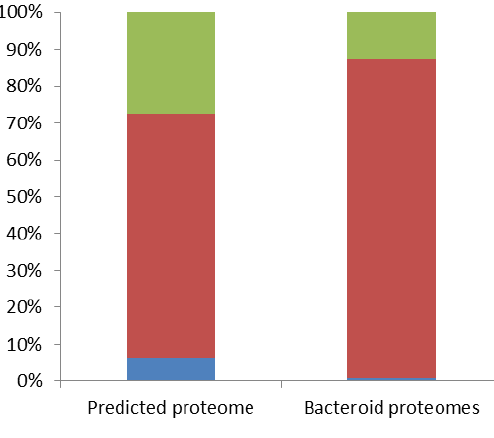
Figure 1. Bacteroid proteomes contain an overrepresentation of core genome encoding proteins and an underrepresentation of ORS278 specific proteins. ORS278 specific proteins are shown in blue, core genome encoding proteins in red and proteins coded by more than one but not all Bradyrhizobial genome in green. The distributions of different classes are not similar (homogeneity CHI -square test, DOF = 2, p = 2.2 × 10 −16